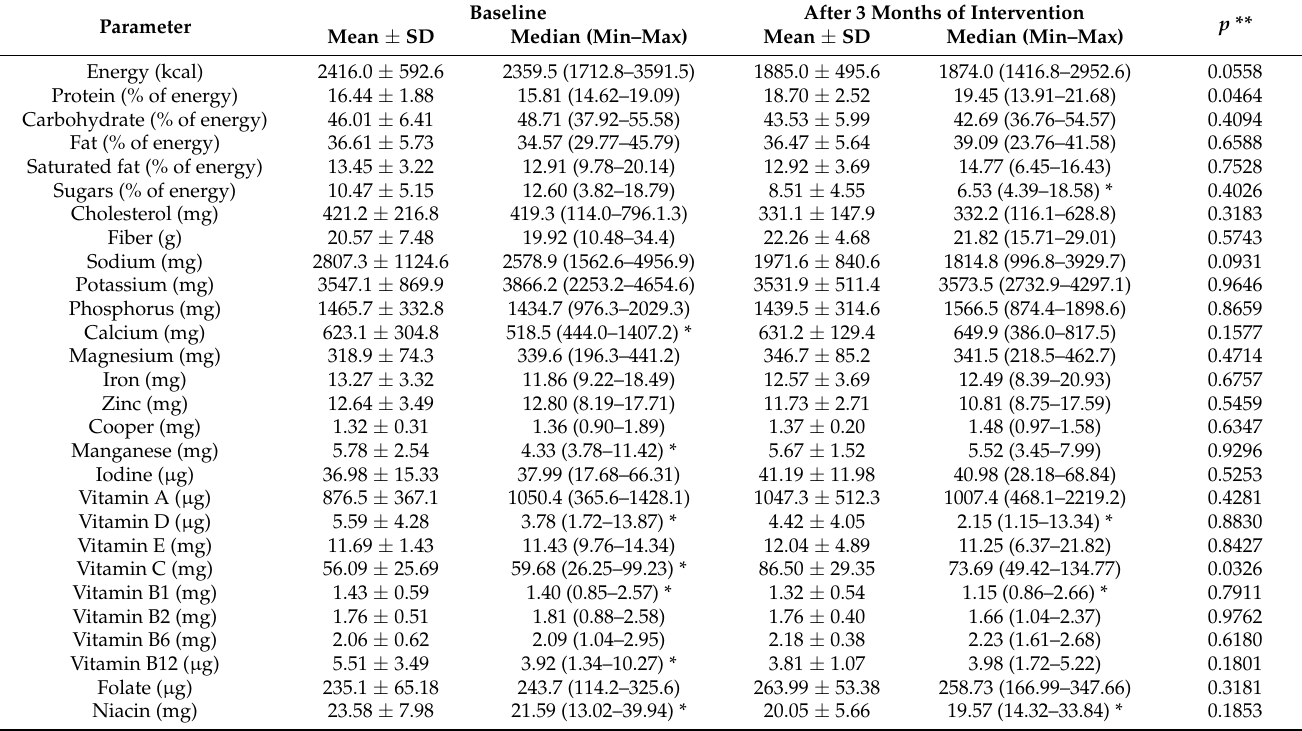
Table 5. The energy and nutritional value of the diet of the male participants at baseline and after 3 months of intervention.